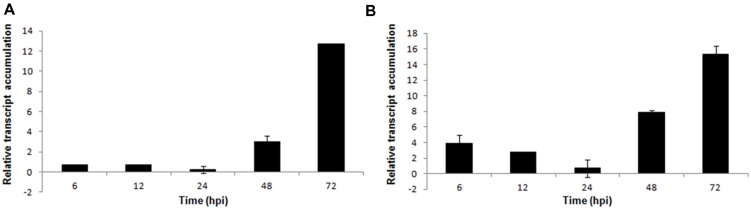
Gene expression profiles of S. sclerotiorum during infection to P. vulgaris. Expression analyses using RT-qPCR were performed and transcript levels were calculated in triplicate using a comparative method. GPDH gene was used as the reference gene in S. sclerotiorum and a health plant as the reference sample. Tissue samples were collected at 6, 12, 24, 48, and 72 hpi. Results are reported as means ± standard deviation (SD) of three samples for each treatment. (A)
oah (oxaloacetate acetylhydrolase). (B)
perilipin.